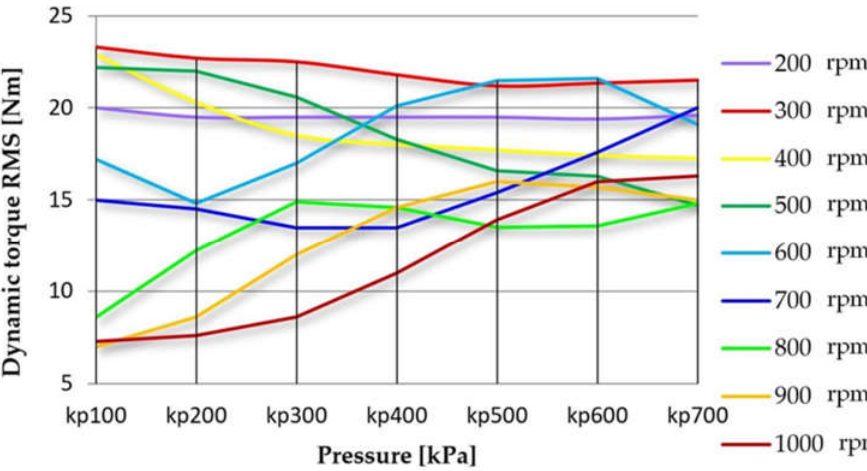
Figure 13. Measurement during constant operating speed with one cylinder deactivation.